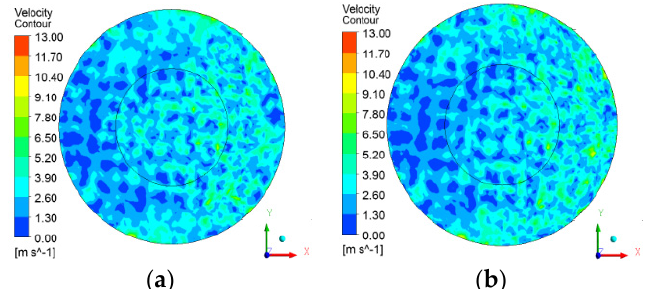
Figure 12. The gas velocity contours of cross ‐ section at z = 1 m under the second spray layer. ( a ) Without deflector; ( b ) With deflector.